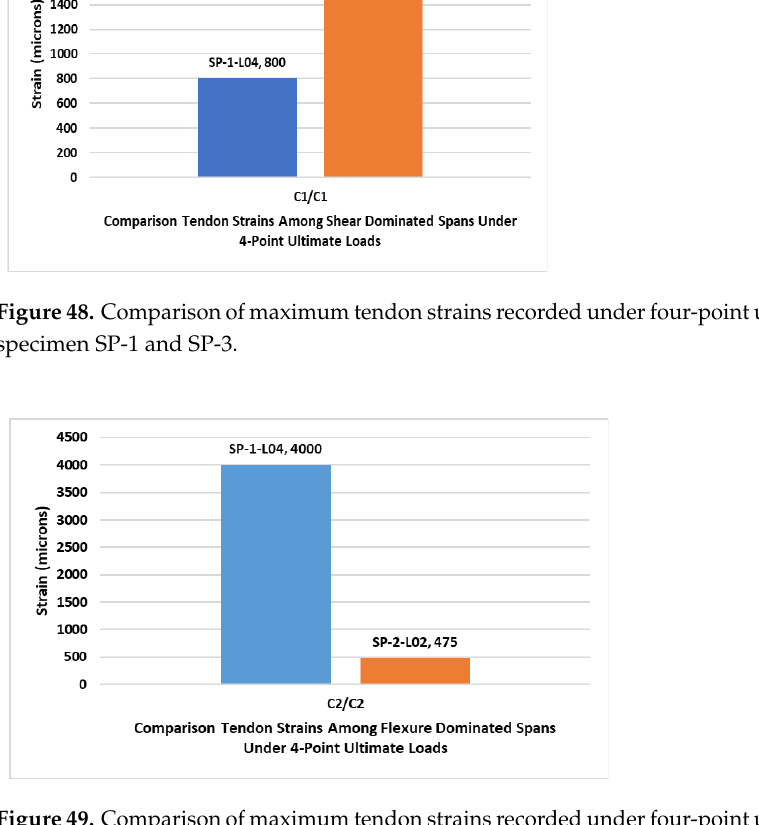
Table 4. Comparison of the ultimate load and deflection for specimen SP-1 and SP-2.